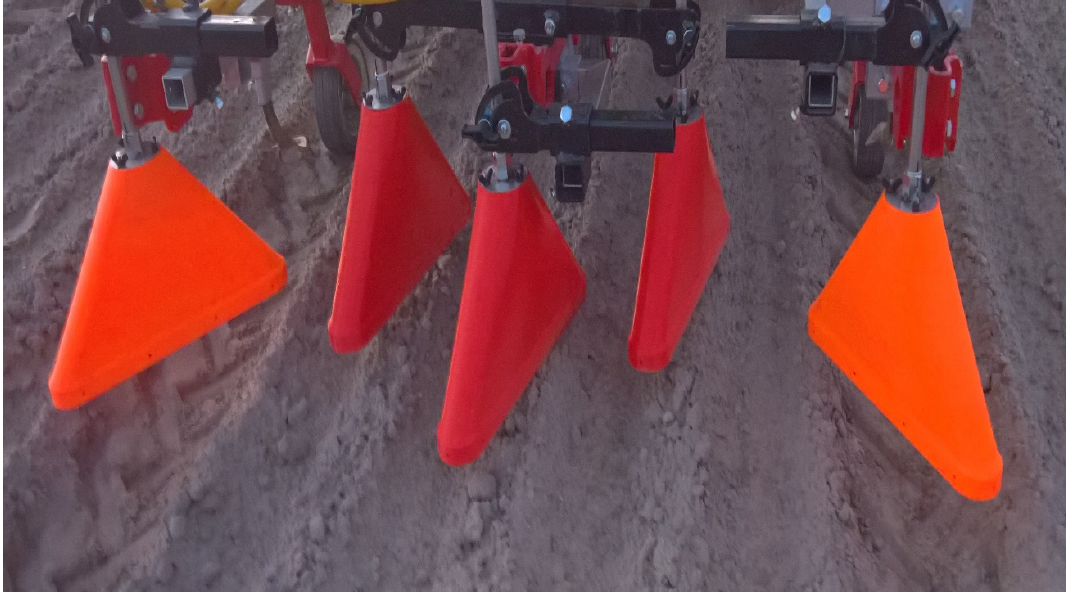
Figure 6. Shielded band sprayer.